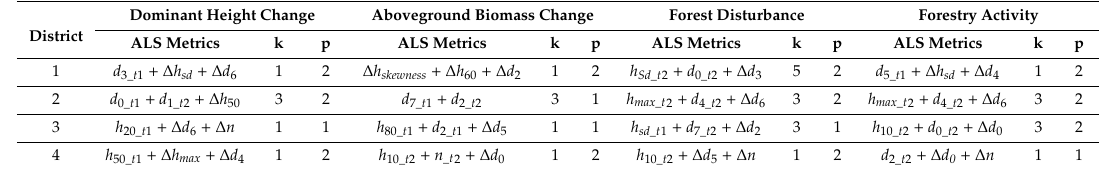
Table 4. k-nearest neighbor classification parameters.